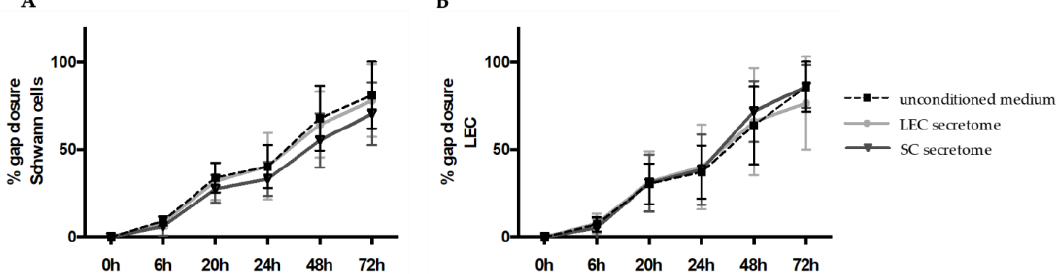
Figure 2. Schwann cell migration was not altered by lymphatic endothelial cell secretome in 2D scratch assay experiments. SCs and LECs were grown until confluency and their conditioned media were collected 24 h before the experiment. Scratches were created on cell monolayers and cell migration in either unconditioned medium or conditioned medium from LECs or SCs was monitored over a total of 72 h. ( A , B ) Quantification of gap closure showed that the secretome of LECs and SCs did not affect the migration of either SCs or LECs. Data are presented as mean ± sd. LEC secretome and SC secretome: n = 15 of 3 independent experiments; unconditioned medium: n = 12 of 2 independent experiments.